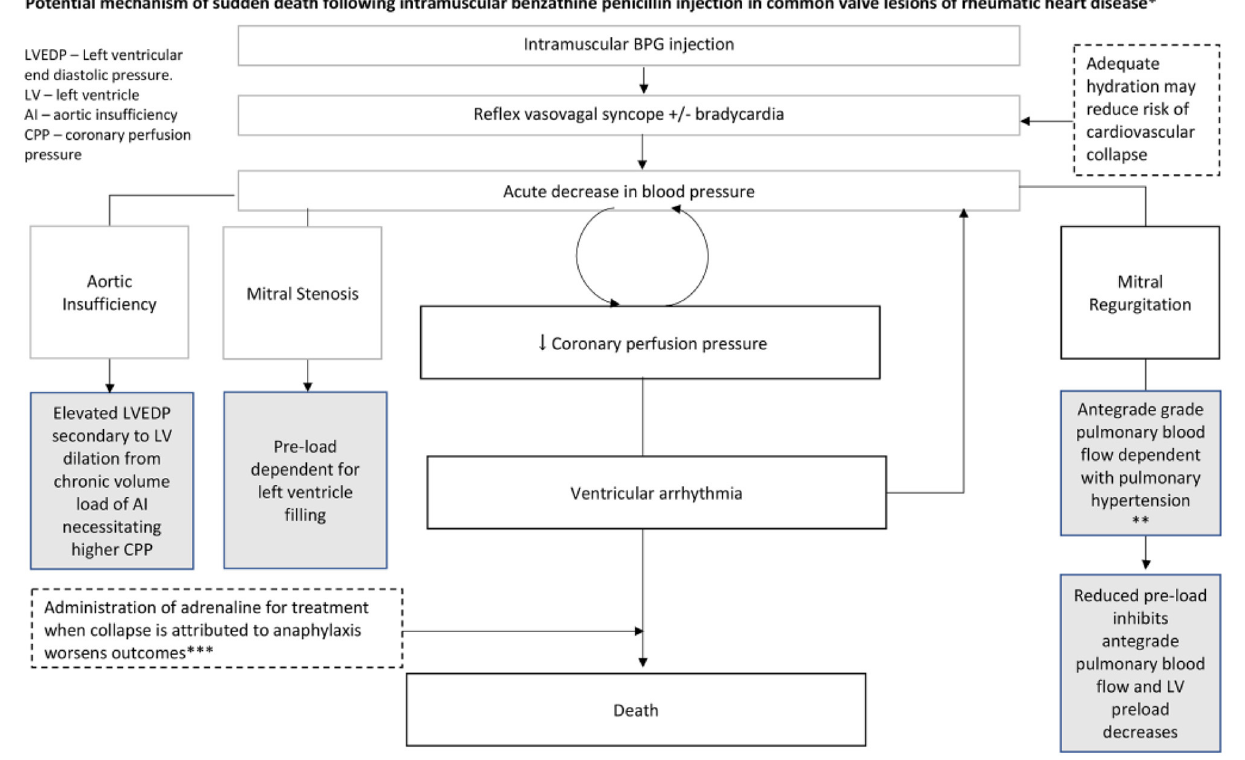
FIGURE 9 | Potential mechanism of sudden death following intramuscular benzathine penicillin injection in common valve lesions of RHD. *Gray boxes reflect contributory or predisposing characteristics of valve lesions. Dashed boxes indicate other potential contributing/mitigating factors. *Plausible mechanism in this case series based on: very rapid onset, no respiratory or skin symptoms and no positive response to epinephrine. BPG, benzathine penicillin G (